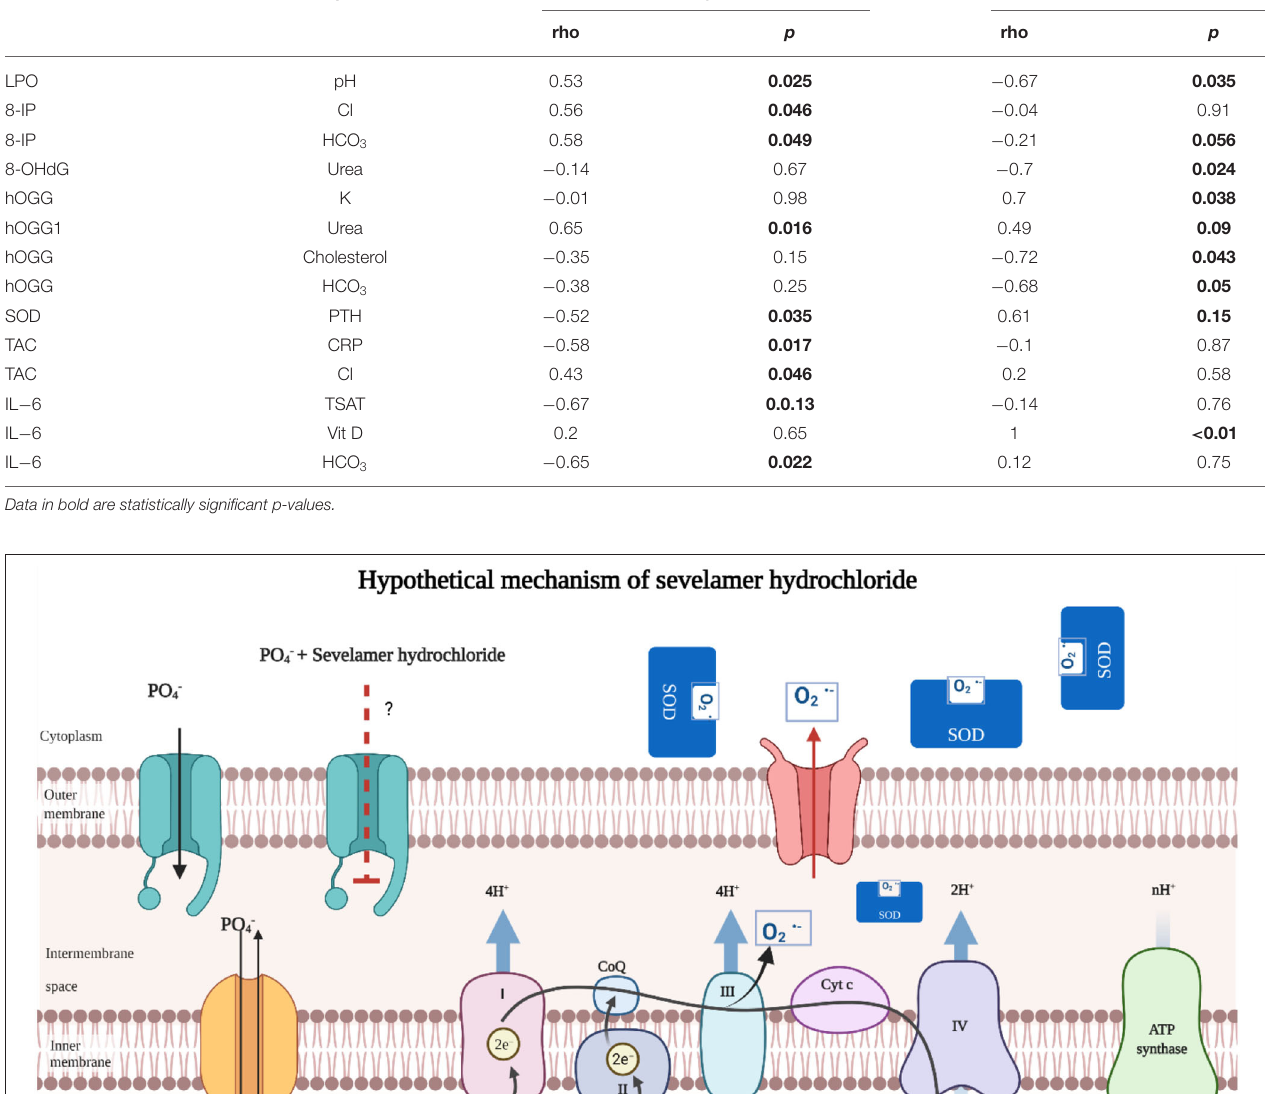
TABLE 5 | Correlation between oxidative stress markers and clinical parameters. Redox biomarker